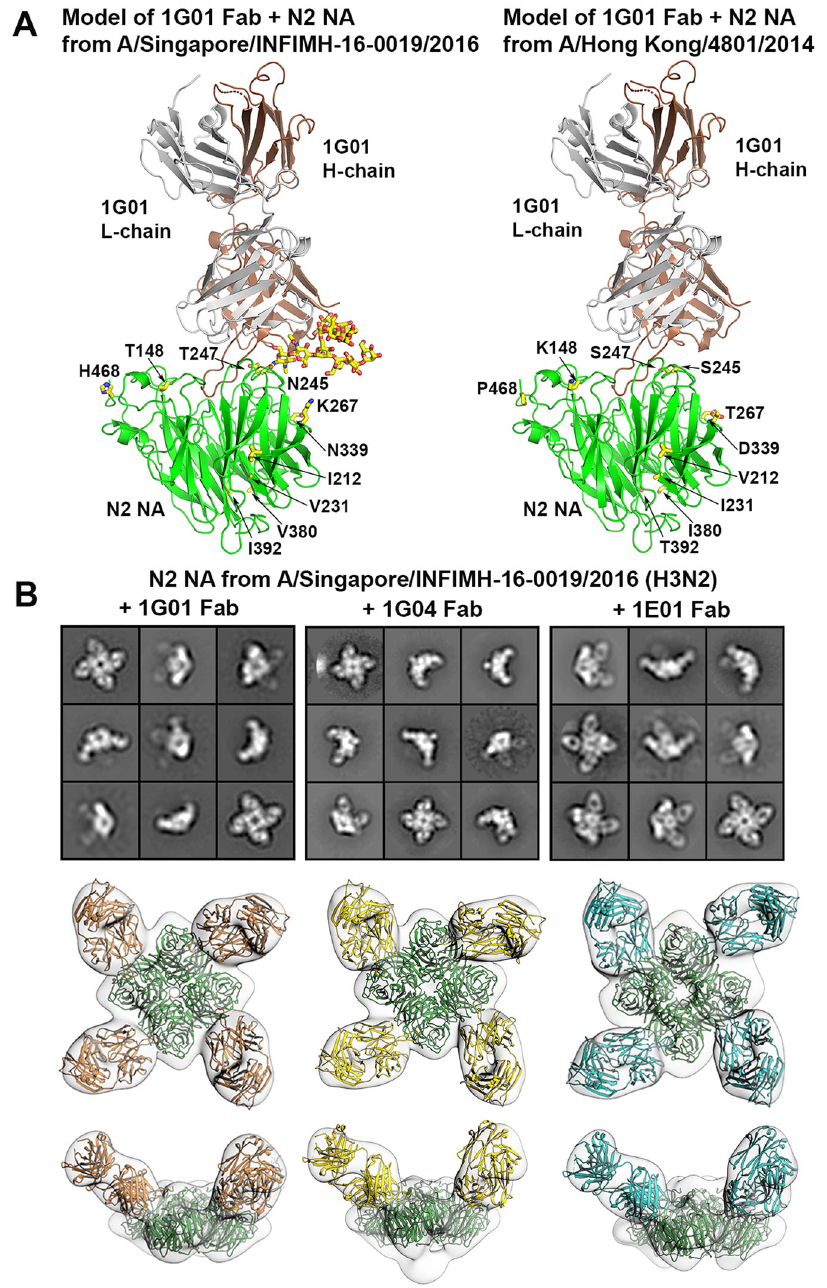
Fig. 2 | Model of the complex of Singapore16 and Hong Kong14 N2 NAs with 1G01 Fab and negative-stain electron microscopy of antibodies 1G01, 1G04, and 1E01 bound to Singapore16 N2 NA. A The Singapore16 N2 NA was modeled withamannose-9glycanatAsn245.The1G01Fabisabletointeractwiththe N2NA (left). The glycan can be accommodated without steric clash with the 1G01 Fab. Amodeloftheinteractionof1G01FabtoHongKong14N2NAisalsoshown(right). NA protomers are colored green. Asn245 and attached glycans, as well as the ten residues that are not conserved between these two N2 NAs in their ectodomain (82 – 469) are shown in sticks and colored with yellow carbon, red oxygen and blue nitrogenatoms.The1G01Fabiscoloredbrown(heavychain)andgray(lightchain).